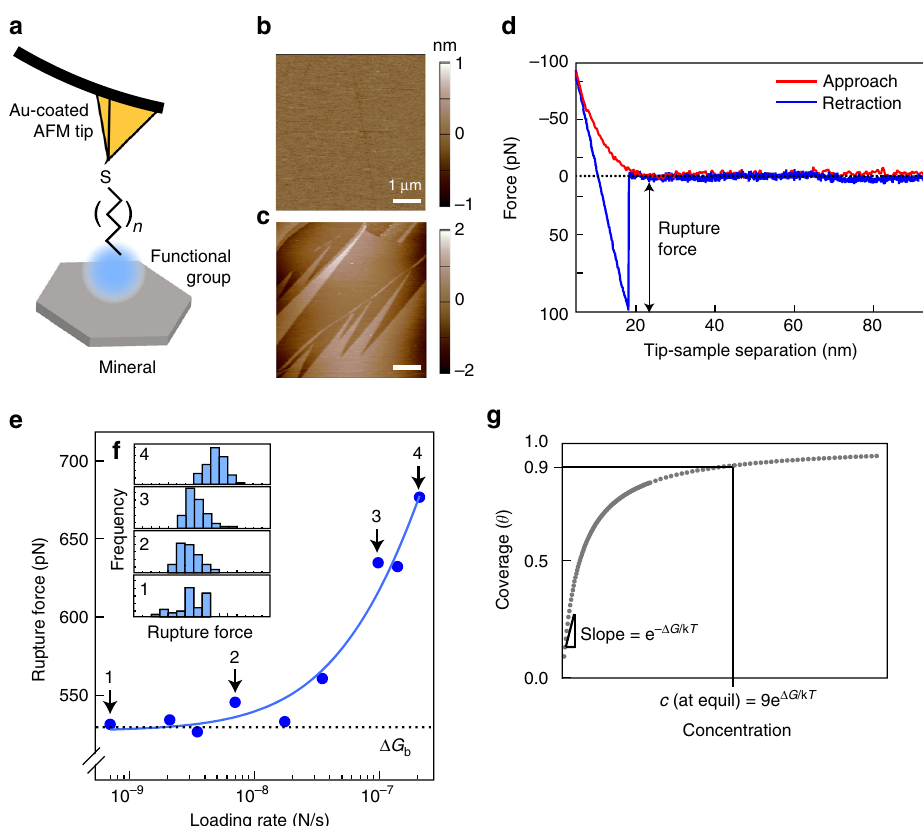
Fig. 2 Dynamic force spectroscopy measurements at the organo – mineral interface. a Functional groups were covalently bound to gold-coated atomic force microscopy (AFM) tips and were used to probe mineral surfaces. Topographical AFM images of b the (001) surface of muscovite mica and c the (010) face of goethite ( bottom ) used in DFS experiments. Scale bars , 1 μ m. d A representative force-distance curve and e a plot of mean rupture force versus loading rate showing increasing rupture force with increasing loading rate. The solid line represents a fi t to the data using a theoretical model that accounts for both equilibrium and kinetic regimes of adsorption and forced desorption (See Eqs. 1 – 3, Methods section). Histograms ( f , inset ) of the force curves from individual points (1) – (4) show the trend of increasing rupture force with increasing loading rate. g To relate values of Δ G to typical measurements seen